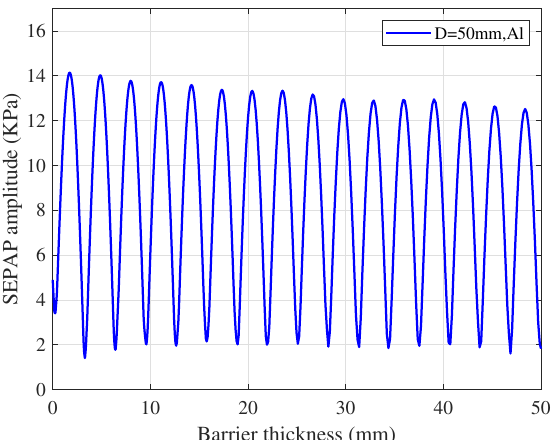
Figure 7. Amplitude variation of Spatial Equivalent Plane Acoustic Pressure (SEPAP) over the thickness the